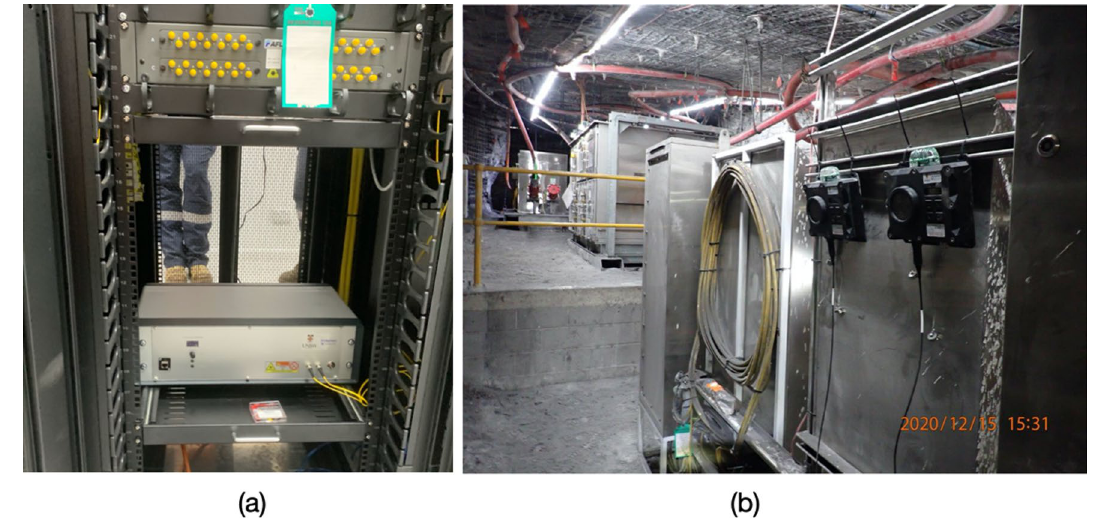
Fig. 6 Installation of the system at Broadmeadow mine. a RTU is installed on the surface at the Comms hut connecting to the mine’s optical